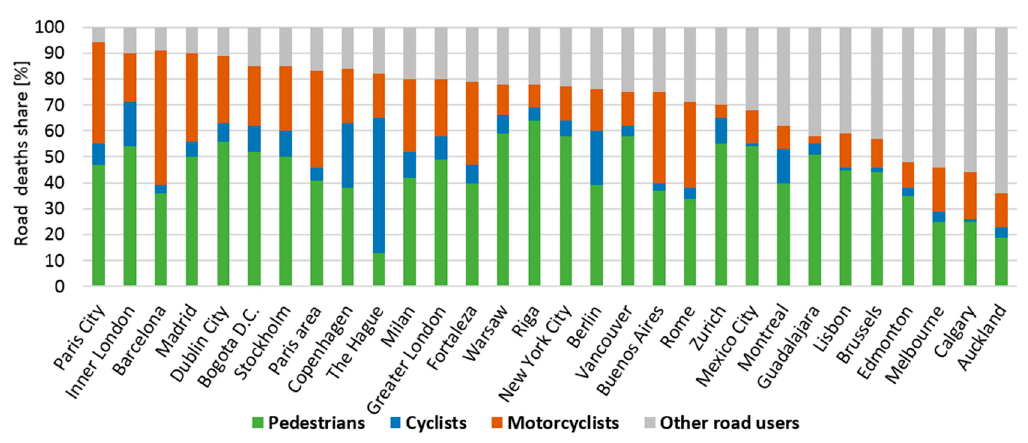
Figure 1. Vulnerable road users’ (VRUs’) road deaths [%] by city in 2013–2015—based on data from Reference [8].